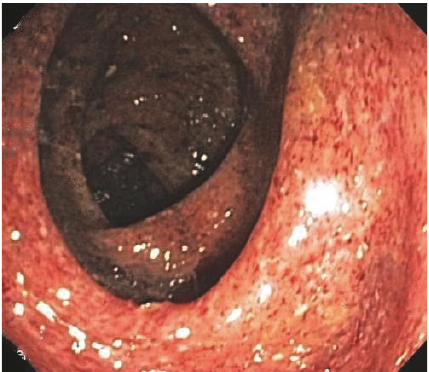
Figure 1: Colonoscopy with intubation of terminal ileum shows diffusely erythematous and granular mucosa with focal exudation affecting the rectum through ascending colon, with sparing of the cecum and terminal ileum. The endoscopic findings are consistent with UC.